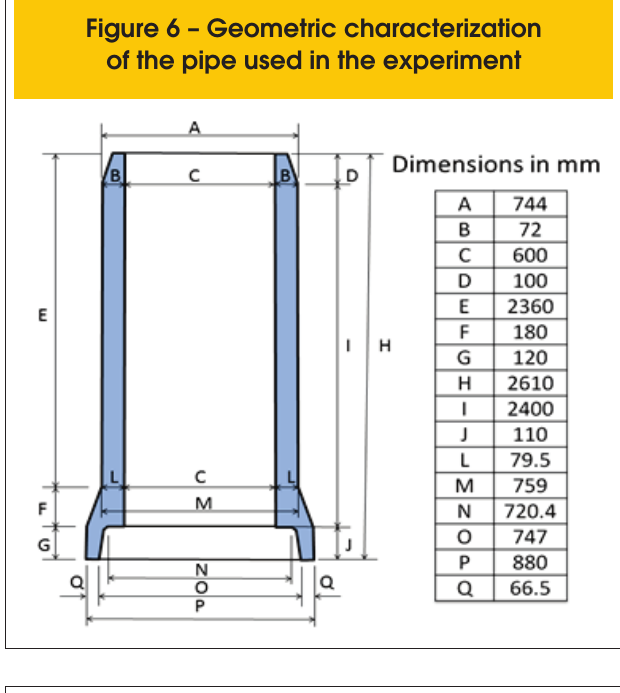
obtained during crushing test of pipes with a 3 fiber consumption of 10 kg/m and with the diametrical displacement measured at the spigot and the